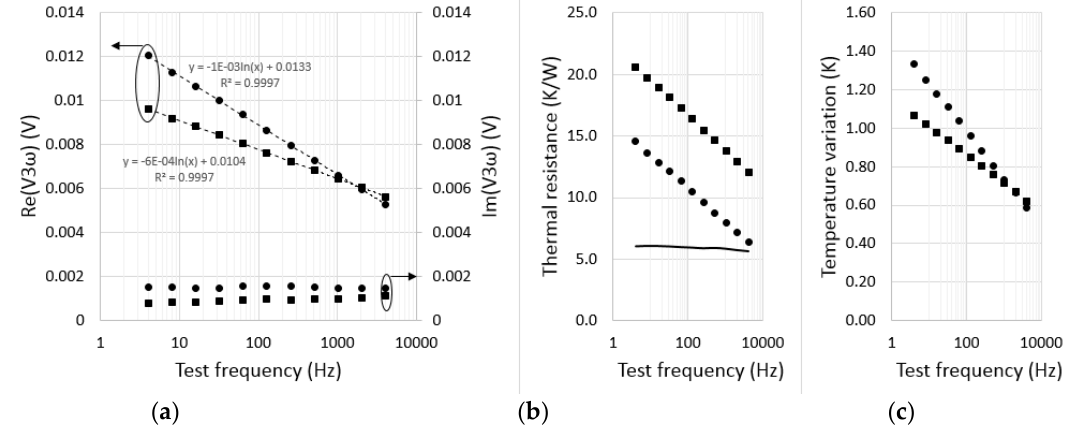
Figure 3. Experimental data vs. frequency for the 5 μ m (squares) and 10 μ m (circles) test line: ( a ) complex 3 ω signal; ( b ) thermal resistance (line indicates the difference between the two sets of data); ( c ) amplitude of temperature